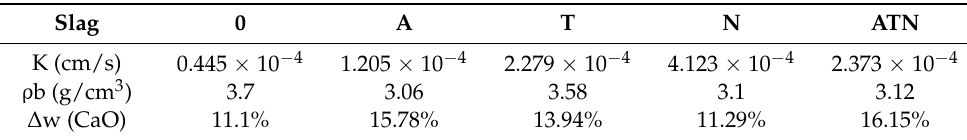
Table 5. Kinetic parameters for lime dissolution in slag. Slag 0